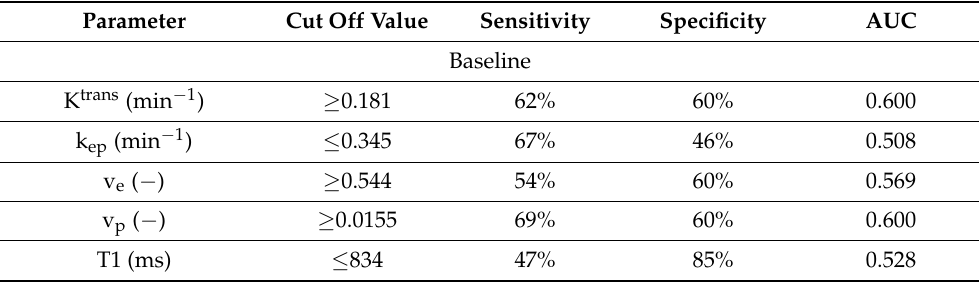
Figure 4. Plot of v p and D at baseline and post-treatment. Both parameters significantly increased after treatment. Table 6. Results of ROC analysis for all MRI parameters at baseline. The AUC, sensitivity, specificity, and cut off value determined with the Youden’s Index is given. If the baseline parameter meets the statement of the cut-off value, the OS is expected to be